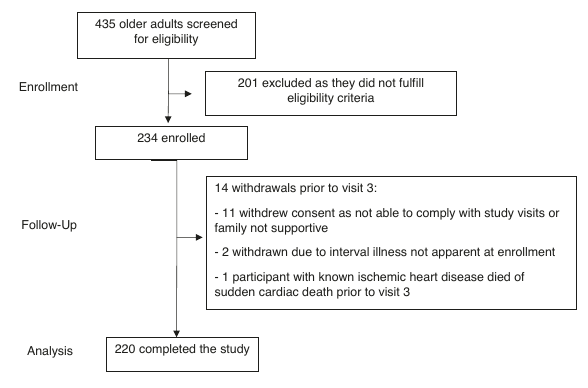
Fig. 1 Study participant fl ow diagram for the DYNAMIC cohort study showing the enrollment, follow-up and analysis